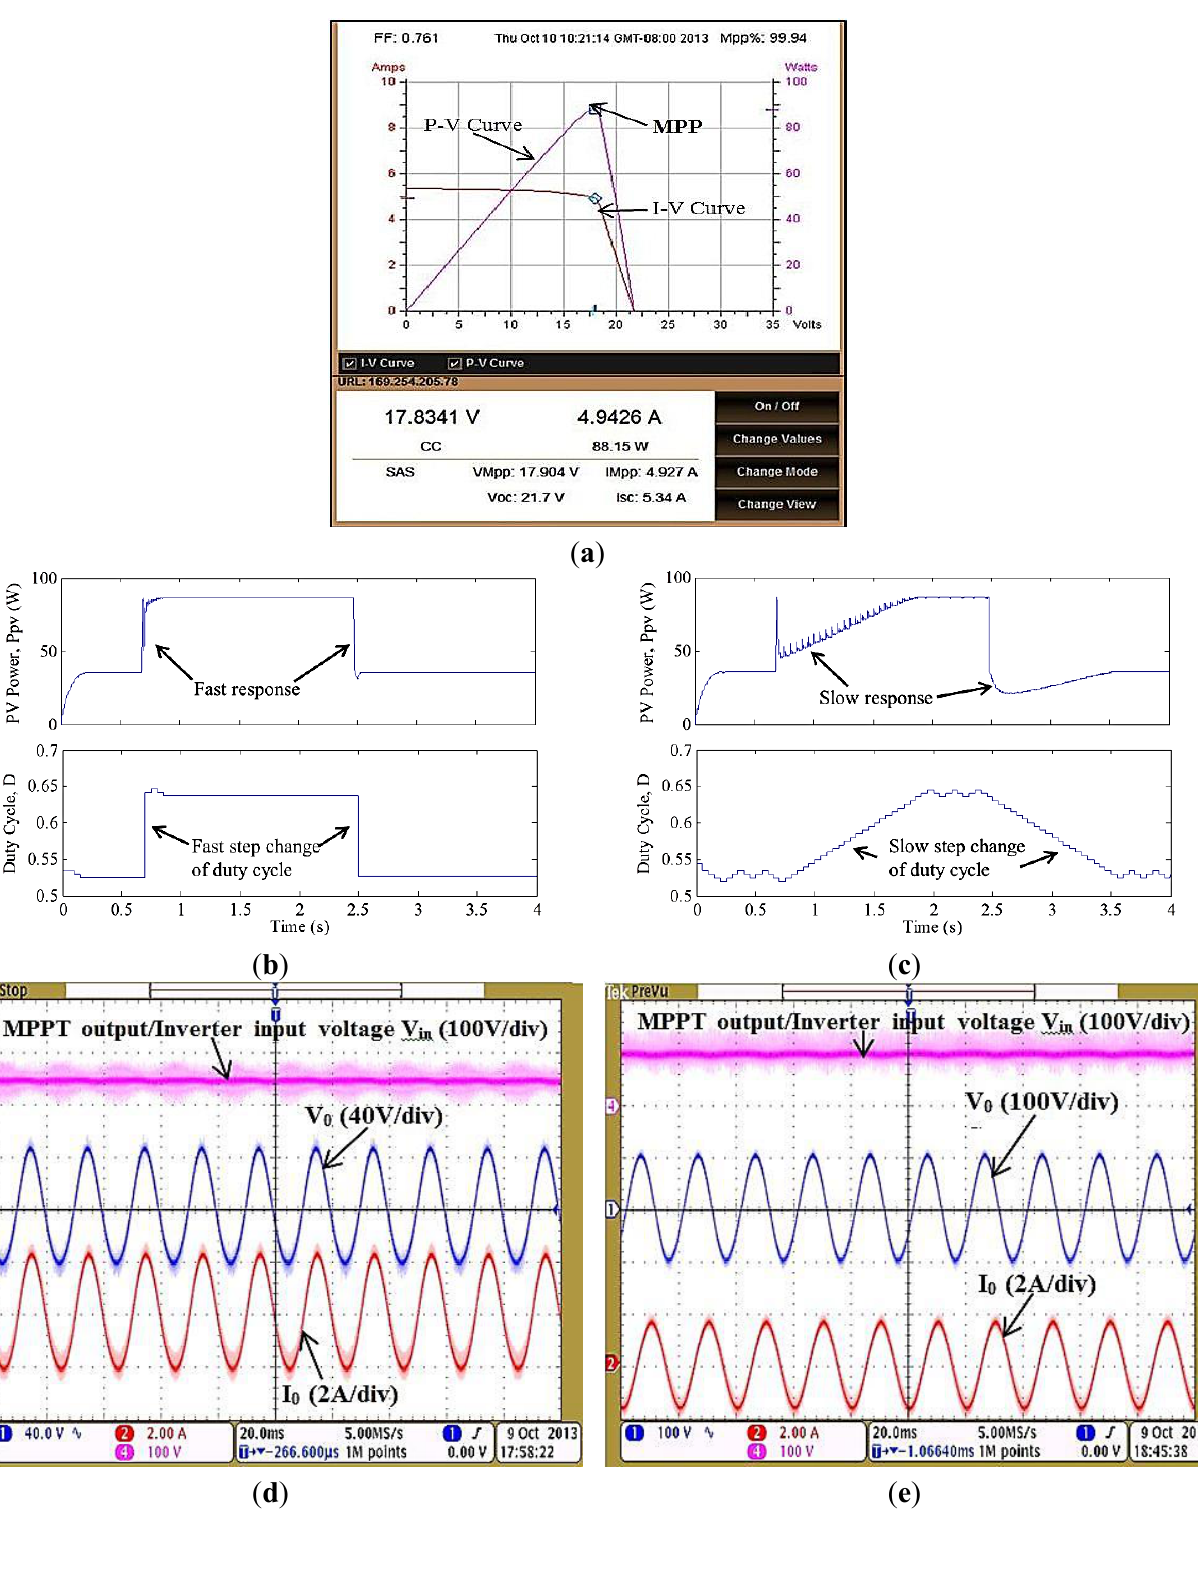
Figure 14. ( a ) Waveform of PV module power and duty cycle of proposed algorithm; ( b ) waveform of PV module power and duty cycle of conventional incremental conductance algorithm; ( c ) I–V curve and P–V curve; ( d ) experimental waveforms of MPPT output/inverter input DC voltage, output voltage, output current for R load; ( e ) experimental waveforms of MPPT output/inverter input DC voltage, output voltage, output current for R-L